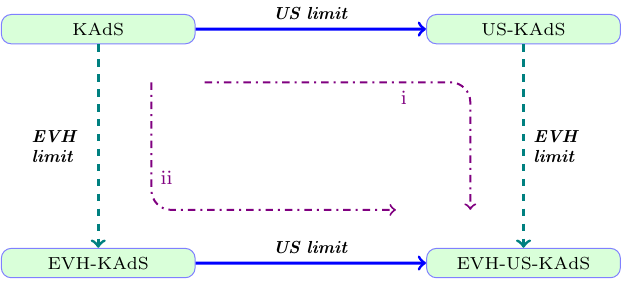
Figure 2 . This diagram shows two different order limits for KAdS black hole. Horizontal arrows (blue) represent the ultraspinning (US) limit. The vertical ones (green) show the EVH limit. We show that in both paths the resulting geometries (US-EVH-KAdS) are exactly the same. where ds 2 is given by eq. (4.3). The first term represents a BTZ black hole. In the case M d − 3 of r + = 0 = a this metric reduces to eq. (4.2). The constructed near horizon geometry